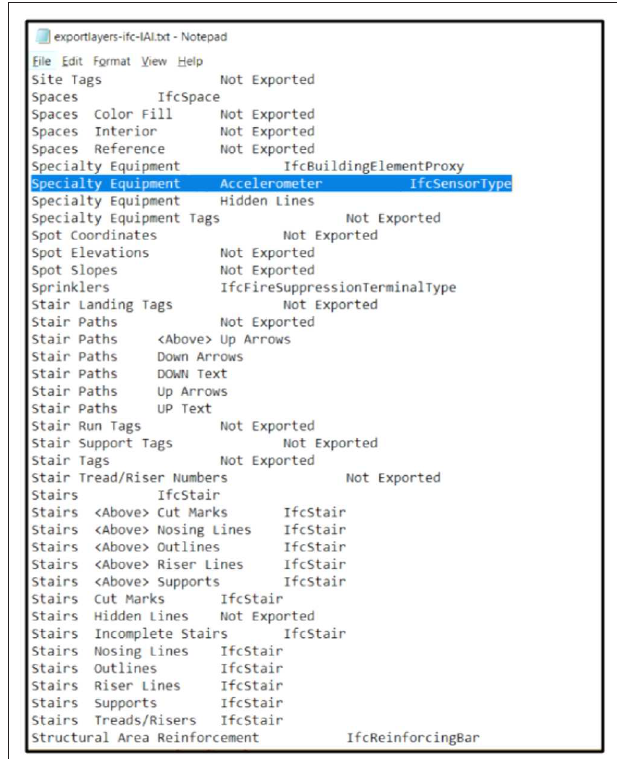
FIGURE 3 | IFC sensor